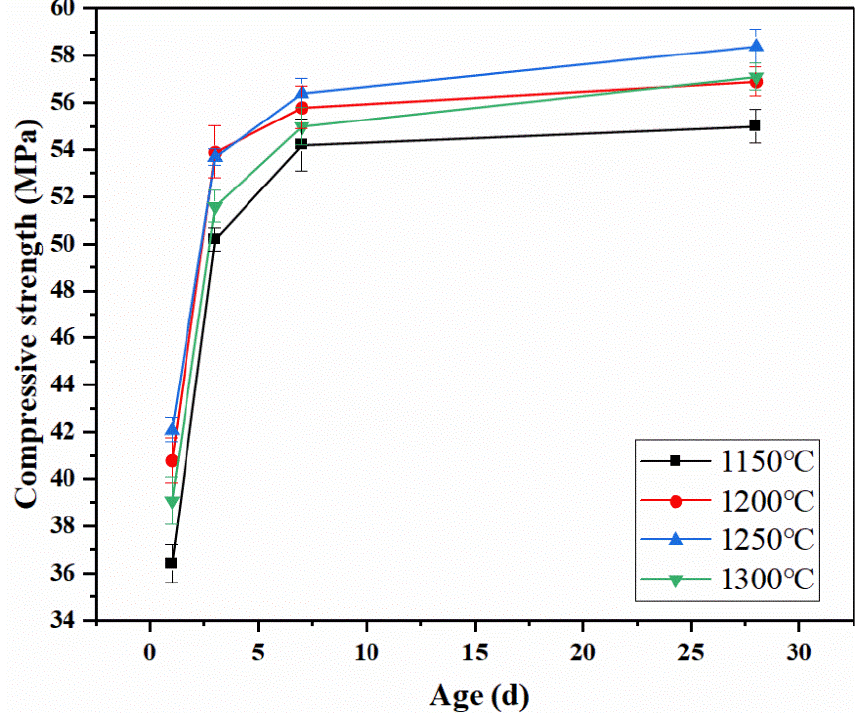
Figure 10. Compressive strength of cement at different firing temperatures. Figure 11 shows the microscopic morphology of S2 at different calcination tempera- tures. Comparing Figure 11a–c, it is found that the morphological characteristics of C 4 A 3 S are the same when the calcination temperature is 1150 to 1250 ◦ C. The size of the fired C 4 A 3 S particles are about 1 to 2 µ m, with a polygonal structure and precise outline, and the inter-particle boundary is clear. When the temperature was increased to 1300 °C, the morphological characteristics of the particles in Figure 11d show that most of the C 4 A 3 S particles had no apparent outline shape, and the particles were fused without obvious boundaries. Therefore, when the calcination temperature is too high, it will affect the particle morphology of C 4 A 3 S, and changing it from a well-defined polygonal structure to a molten state will affect the cement’s hydration